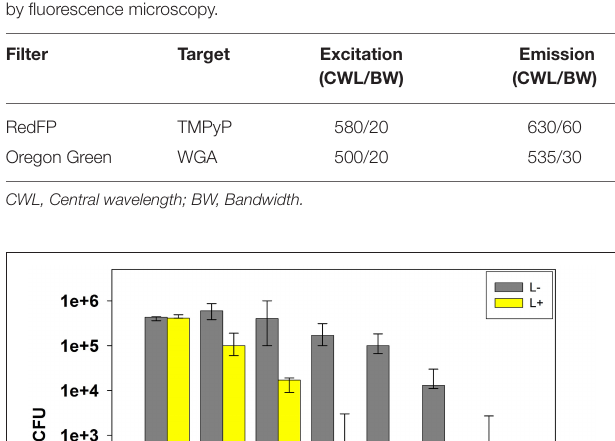
with the AxioVision Rel. 4.9.1 software package (Zeiss, Oberkochen,